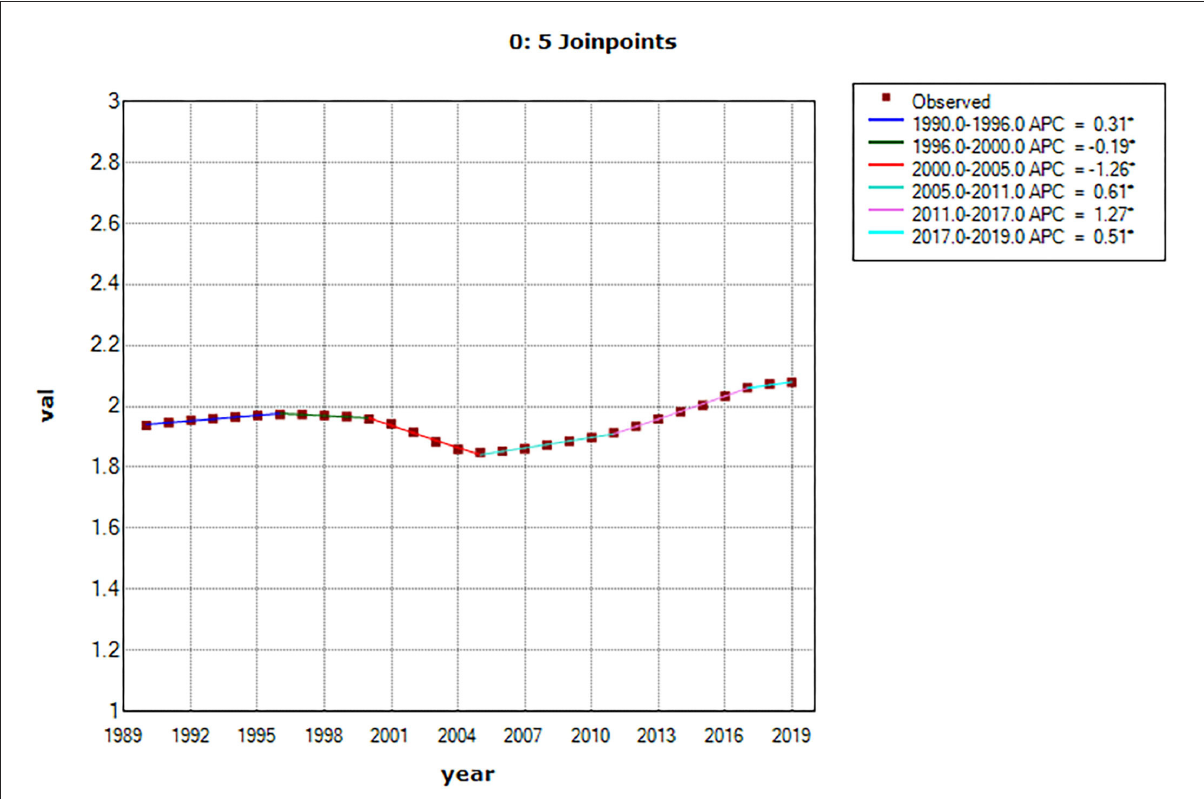
FIGURE5 The results of joinpoint model and the long-term trend of